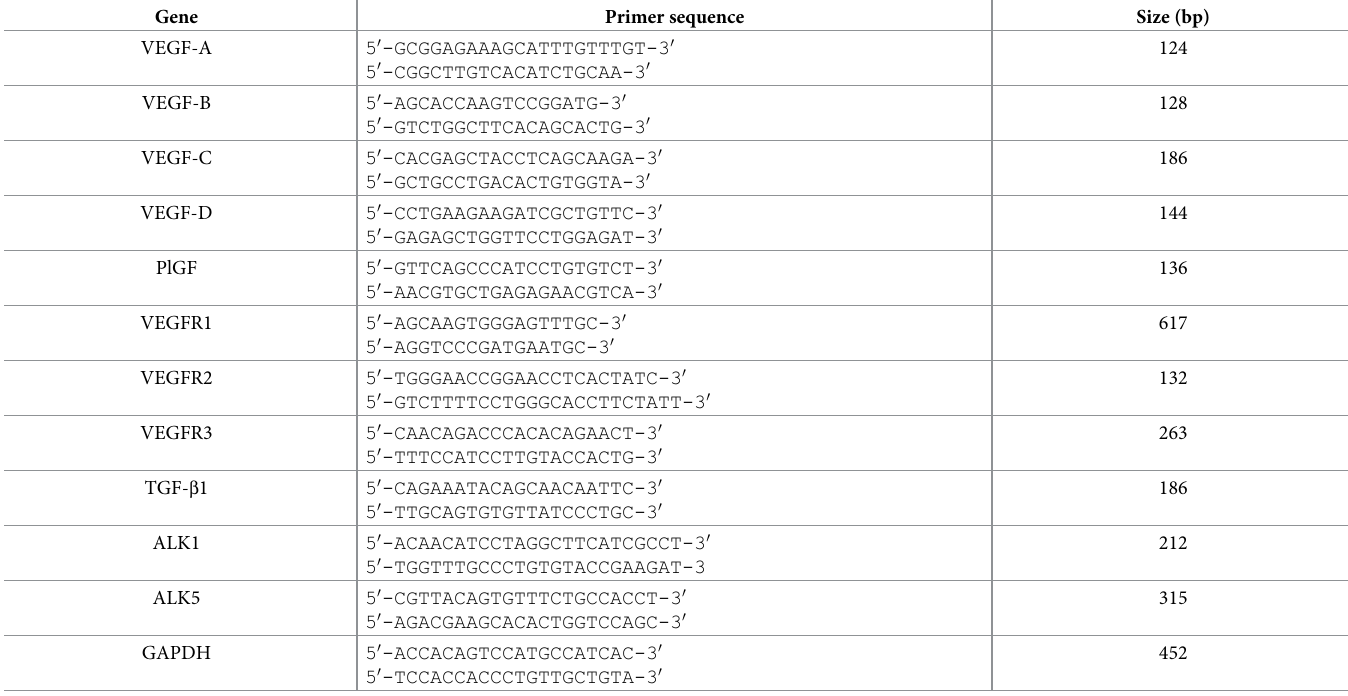
Table 1. Oligonucleotide primers used for gene expression analysis.